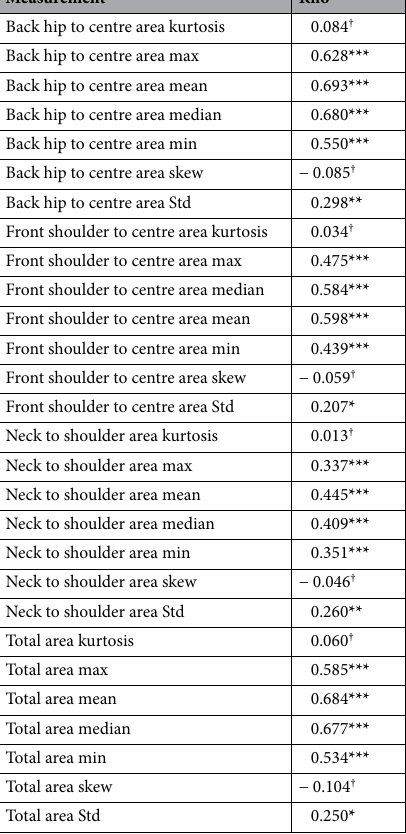
Table 2. Pearson’s correlation coefficients for the various areas of the back with relation to the lameness score of the cow 0–3. a The individual area calculations are outlined in “Back area analysis”). The indicated probability thus: † P < 0 . 10 , * P < 0 . 05 , ** P < 0 . 01 , *** P < 0 .